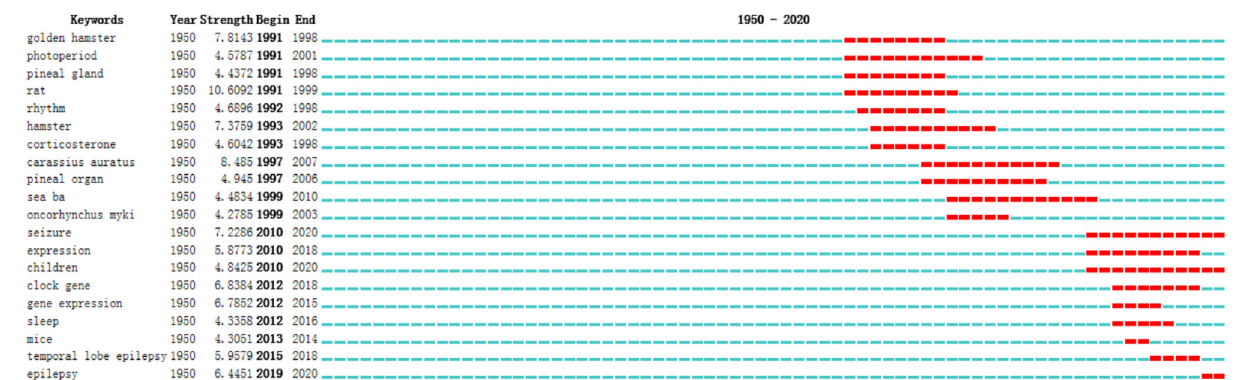
FIGURE 7 | Top 20 keywords with the strongest citation bursts.